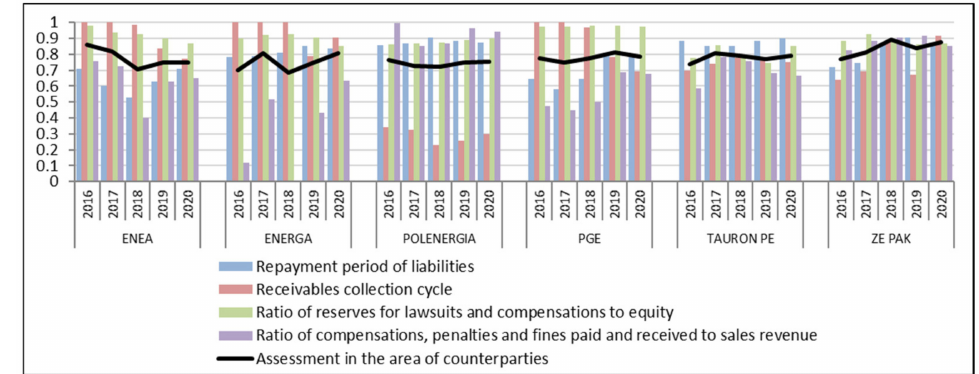
Figure 4. Assessment of the investigated companies’ activities in the area of counterparties.